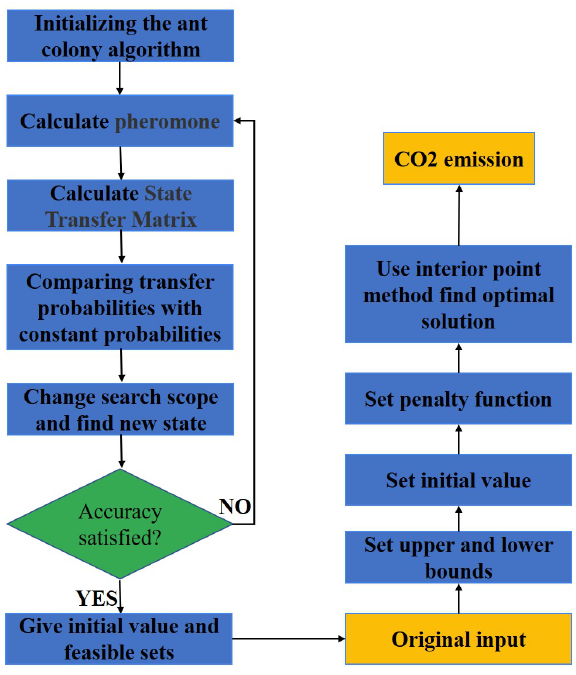
Figure 1. Flow chart of ACA–IPFM model.